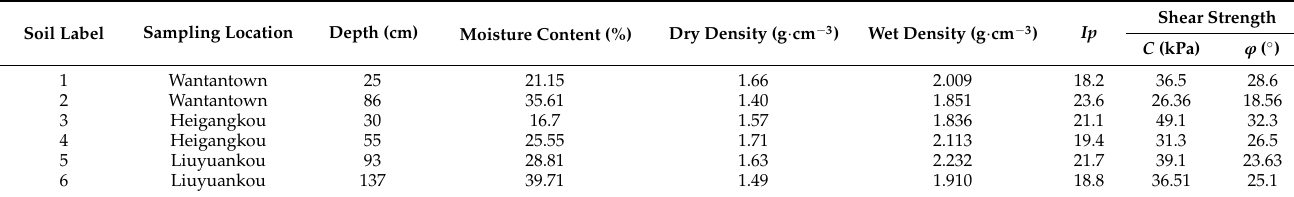
Table 2. Part test results of the brown soil.